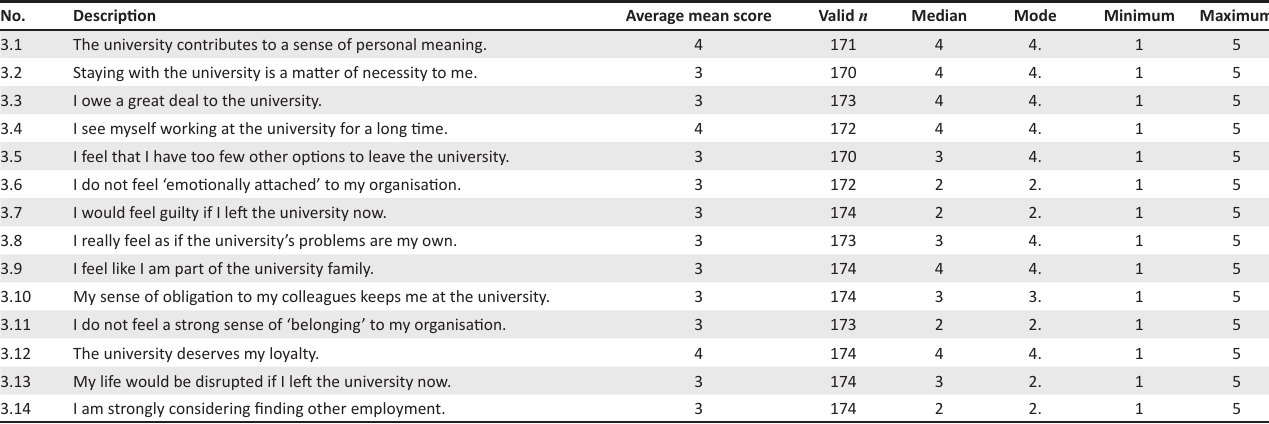
TABLE 3: Descriptive statistics for organisational commitment. No. Description